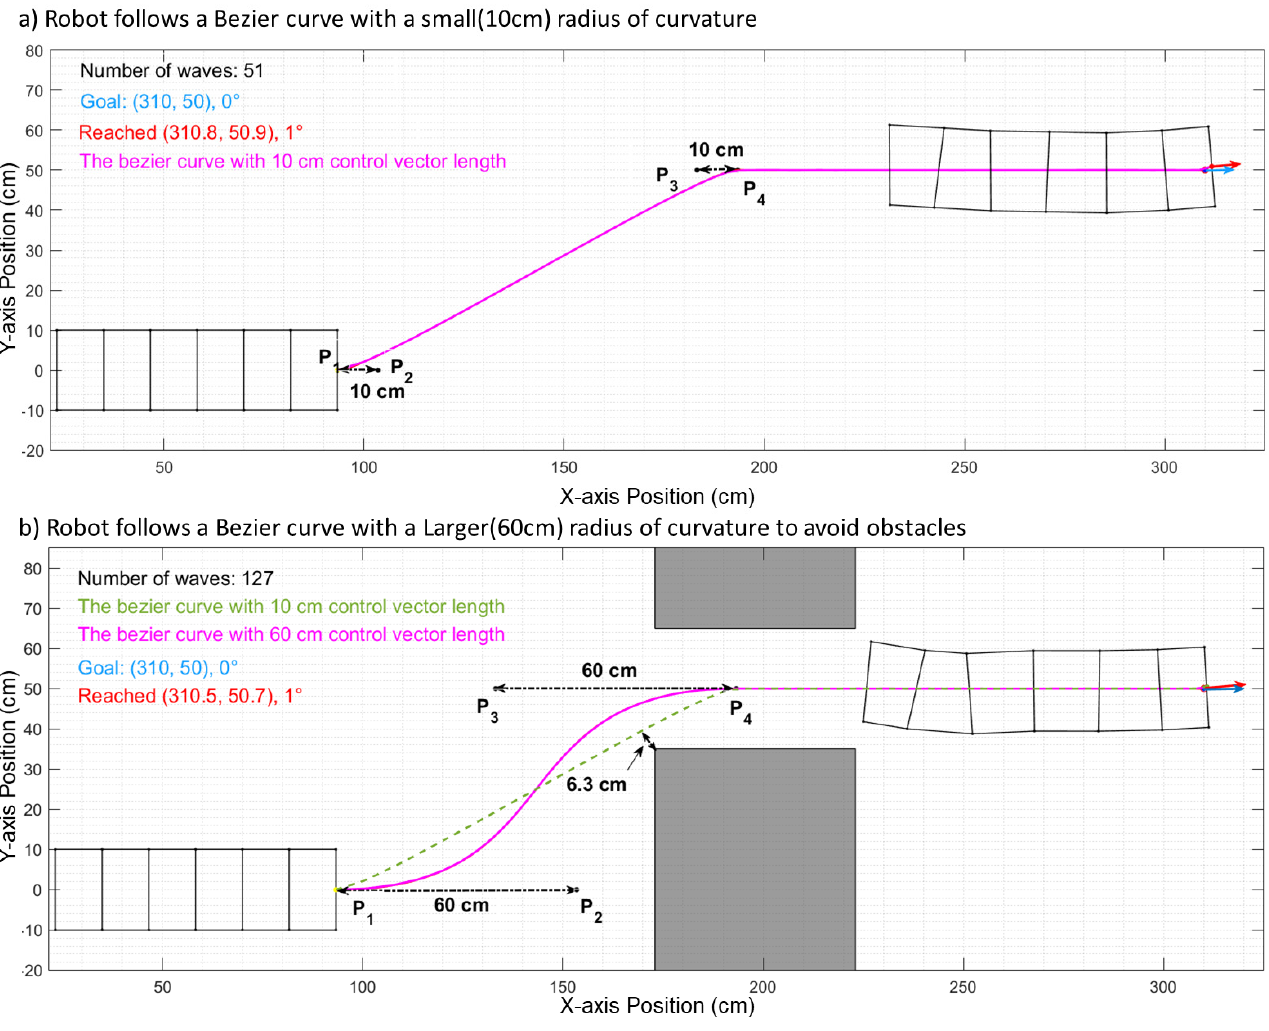
Figure 5. Comparisons of different Bézier curves to reach the same goal in different situations. The Bézier curve of case ( a ) is more linear than that in case ( b ). ( a ) The length of the control vectors is 10 cm. It takes 51 waves for the robot to reach the goal. ( b ) Due to obstacles, the Bézier curve requires a larger turning radius for better passing ability. The length of the control vectors is 60 cm. It takes 127 waves for the robot to reach the goal. For reference, the green dotted line in ( b ) is the path in ( a ).